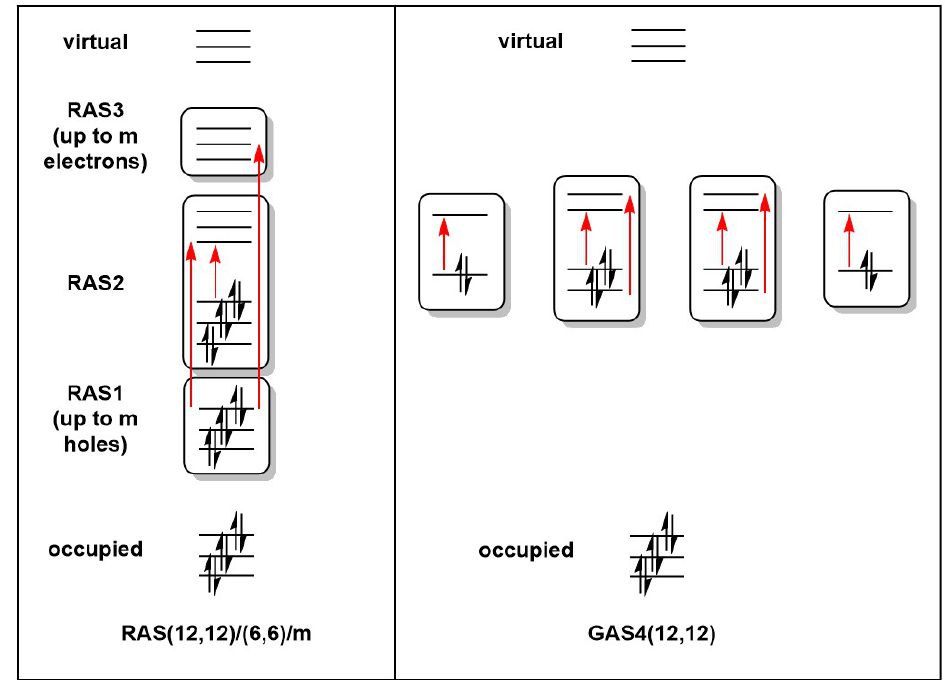
Figure 2. Representation of the Restricted and Generalized Active Space partitions for a (12,12) active